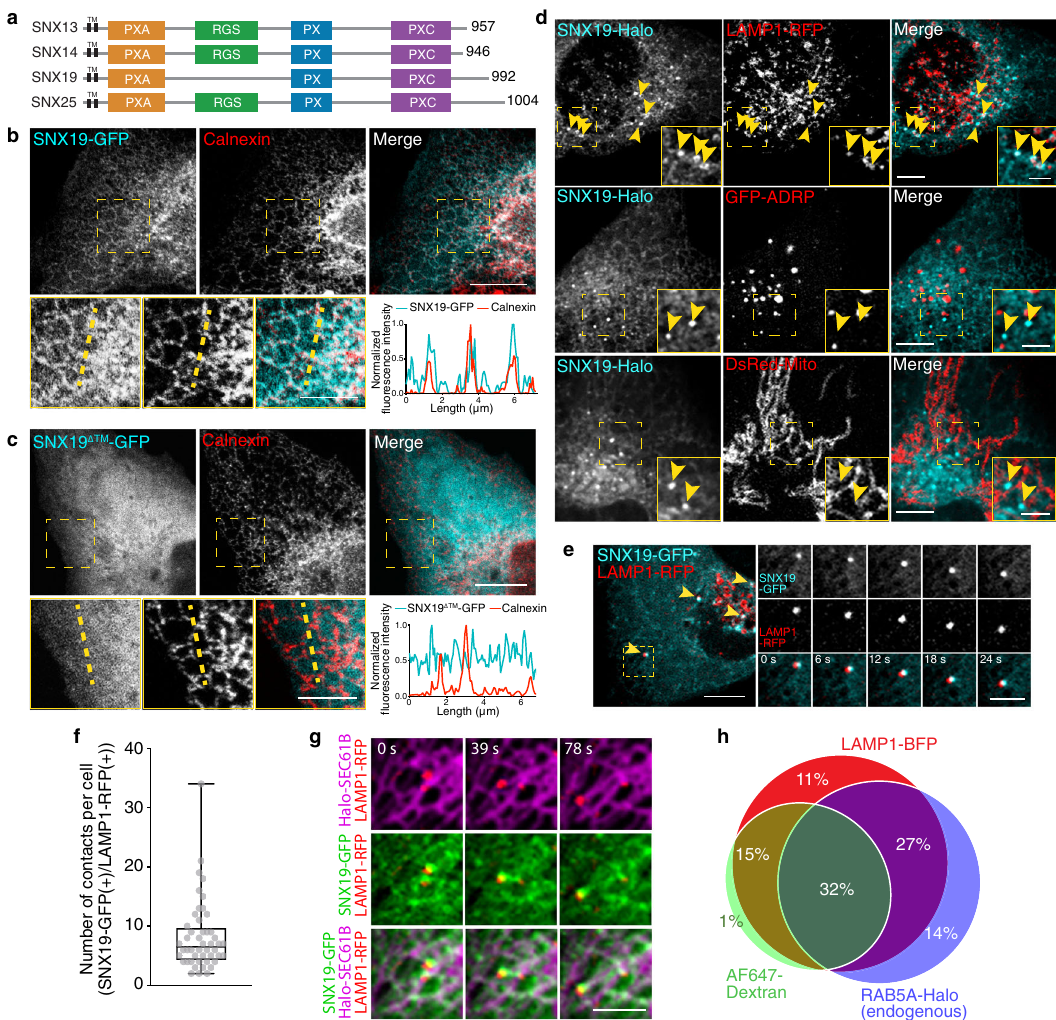
Fig. 1 SNX19 is an ER-resident protein that makes contacts with endolysosomes. a Scheme of mammalian SNX19 and its paralogs. TM transmembrane domains, PXA PX-associated domain, RGS regulator of G-protein signaling domain, PX phagocyte oxidase (phox) homology domain, PXC C-Nexin domain. Amino-acid numbers of each protein are indicated on the right. Scheme not to scale. b , c U-2 OS cells were transfected with plasmids encoding SNX19-GFP ( b ) or SNX19 Δ TM -GFP (lacking the TM domains) ( c ), fi xed, immunostained with antibody to calnexin, and imaged by confocal microscopy. The bottom rows show zoomed in images of the indicated areas at higher contrast. Fluorescence intensity along the yellow dashed line was measured, normalized by setting the highest value for each channel to 1 and scaling all other values, and represented as a line scan (bottom right in each panel). d U-2 OS cells were co-transfected with plasmids encoding SNX19-Halo (subsequently labeled with Janelia Fluor 646 dye) and either LAMP1-RFP (ELs), GFP-ADRP (LDs), or DsRed-Mito (mitochondria), and imaged live by confocal microscopy. Yellow arrowheads indicate representative SNX19-Halo puncta. e U-2 OS cells were transfected with plasmids encoding SNX19-GFP and LAMP1-RFP and analyzed by time-lapse, live-cell imaging (Supplementary Movie 1). Arrowheads point to representative SNX19-GFP – LAMP1-RFP contacts in one cell. Small images are frames from a video of the dashed box in the large image, showing individual and merged channels over time. f Number of puncta positive for SNX19-GFP and LAMP1-RFP per cell was quanti fi ed from 48 cells across 5 live- cell imaging experiments conducted as in e . The data were represented as a dot plot of individual values overlaid with a box and whiskers plot with the box extending from 25th to 75th percentiles, the horizontal line representing the median, and the whiskers representing the minimum and maximum values. g U-2 OS cells were co-transfected with plasmids encoding Halo-SEC61B (subsequently labeled with Janelia Fluor 646 dye), SNX19-GFP, and LAMP1-RFP, and imaged live by confocal microscopy. The images show a SNX19-positive EL and the ER over time. h HeLa RAB5A-Halo-KI cells were co-transfected with plasmids encoding SNX19-GFP and LAMP1-BFP, and incubated for 16 h with Alexa Fluor 647-Dextran followed by a 2-h chase, endogenously tagged RAB5A-Halo (early endosome marker) was labeled with Janelia Fluor 549 dye, and cells were imaged live by confocal microscopy. The percentage of SNX19-GFP puncta that contained one or more of the markers was calculated and represented as a Venn diagram. A total of 135 contacts across 2 experiments, 15 – 20 cells per experiment, were quanti fi ed. Source data are provided as a Source Data fi le. Scale bars: 10 μ m in b – e , 5 μ m insets and in g . given time (Fig. 1f). Further live-cell imaging showed that cases) (Fig. 1e and Supplementary Movie 1), indicating that these SNX19-GFP foci associated with LAMP1-RFP were continuous puncta represent bona fi de ER – EL associations. Quanti fi cation of with a fainter SNX19-GFP signal distributed throughout the ER, puncta containing both SNX19-GFP and LAMP1-RFP and that identi fi ed by labeling with Halo-tagged SEC61B (Fig. 1g). co-localized for at least 10 s in live cells (a rather strict Overexpressed LAMP1 has been shown to localize not only to requirement) revealed an average of 8 contacts per cell, with lysosomes but also to early and late endosomes 23 . Thus, to better 25% of cells exhibiting between 10 and 35 contacts per cell, at any NATURE COMMUNICATIONS| (2021) 12:4552